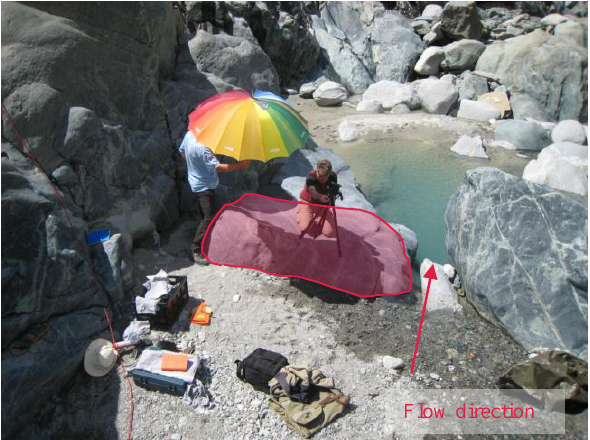
Figure 2. Data acquisition at the Gornera field site.